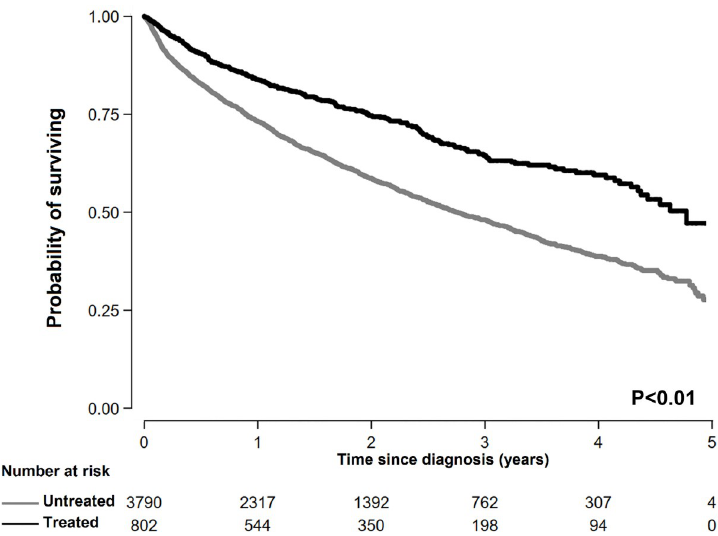
Fig 3. Kaplan–Meier survival curves of patients with hepatitis C virus -related hepatocellular carcinoma according to prior hepatitis C virus treatment.